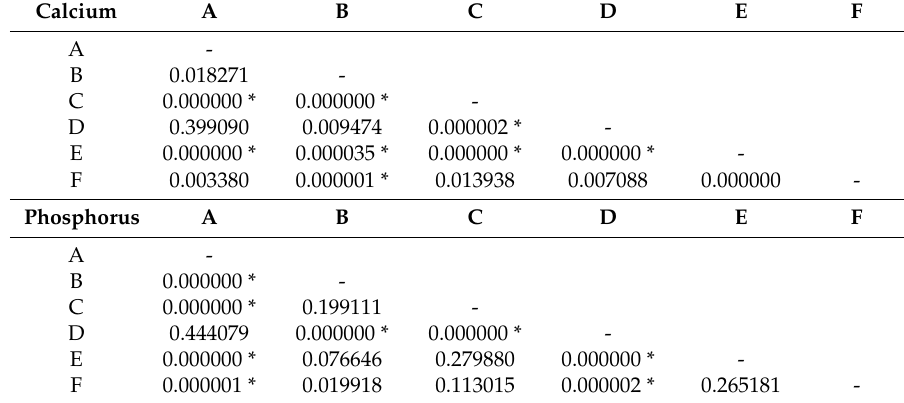
Table 2. Analysis of calcium and phosphorus ion content in solution after the use of remineralizing agents.